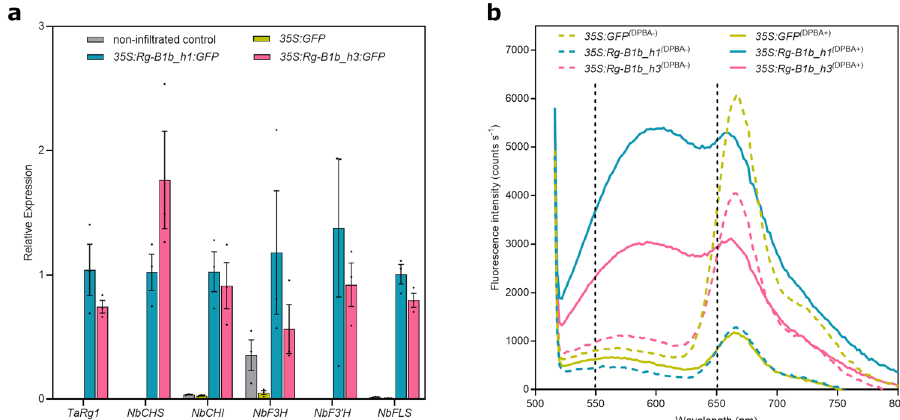
Fig. 4 Transient expression of Rg-B1 in Nicotiana benthamiana . a Transcript levels of endogenous fl avonoid biosynthetic genes in N. benthamiana in fi ltrated with the 35 S:GFP vector control and the Rg-B1 -overexpressing constructs 35 S:Rg-B1b_h1:GFP and 35 S:Rg-B1b_h3:GFP . Error bars represent standard errors of three biological replicates. b Spectro fl uorometric pro fi le of agroin fi ltrated leaves pre and post DPBA staining. The region between the two vertical dotted lines from 550 to 650 nm coincides with the previously reported peak for the fl avonol quercetin 48 . The peak from ̴ 665 to 685 nm is auto fl uorescence from chlorophyll/chloroplasts 49